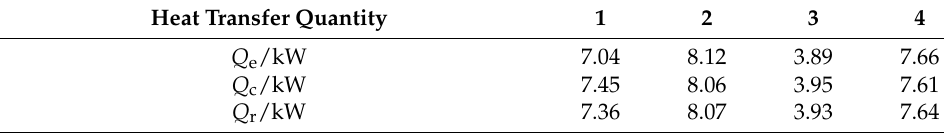
Figure 3. The relationship diagrams of Q c and Q e calculated with the experimental data. Table 4. Results contrast of the experimental and calculated heat exchange.